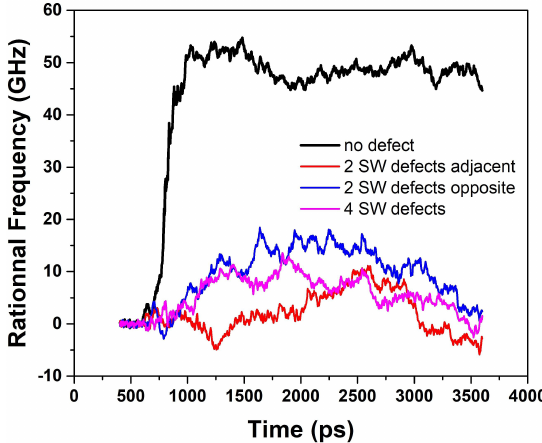
Figure 10: (a) Rotational frequencies of outer tube for the double- walled system containing no defect, 2 SW defects adjacent, 2 SW defects opposite, 4 SW defects in the inner